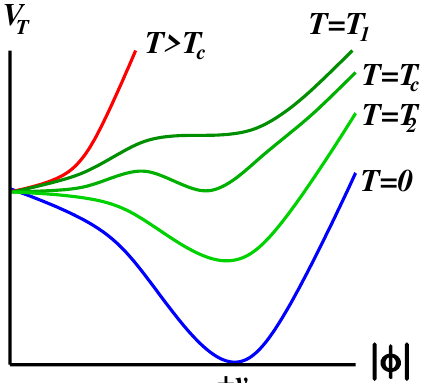
( φ ) at different T (red) the potential has a minimum c > T (dark 1 c